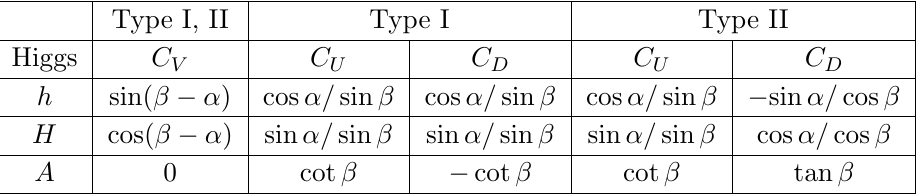
Table 1 . Tree-level vector boson couplings C V ( V = W; Z ) and fermionic couplings C U and C D to up-type and down-type fermions respectively, normalized to their SM values for the two scalars h; H and the pseudoscalar A in Type I and Type II